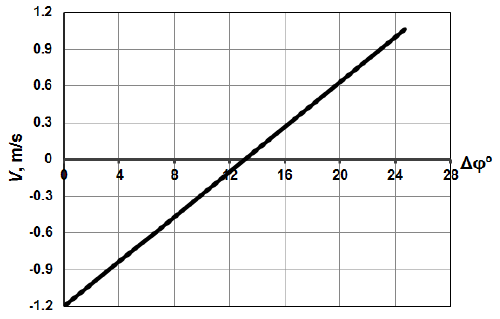
Figure 7. Sliding speed in the engagement. According to the calculated data of the gears, the reduction of the initial thickness S near the root of the 0 composite teeth is calculated. Accordingly, the initial is 7.39 mm. According to fig. 6 the teeth thickness S 0 wear of the gears is: PA6 + 30CF - h ≈ 0.21 mm, PA6 + s ≈ 0.26 mm. Due to wear, the teeth thickness S 30GF - h s h is: PA6 + 30CF - 7.18 mm (<2.84%), PA6 + 30GF